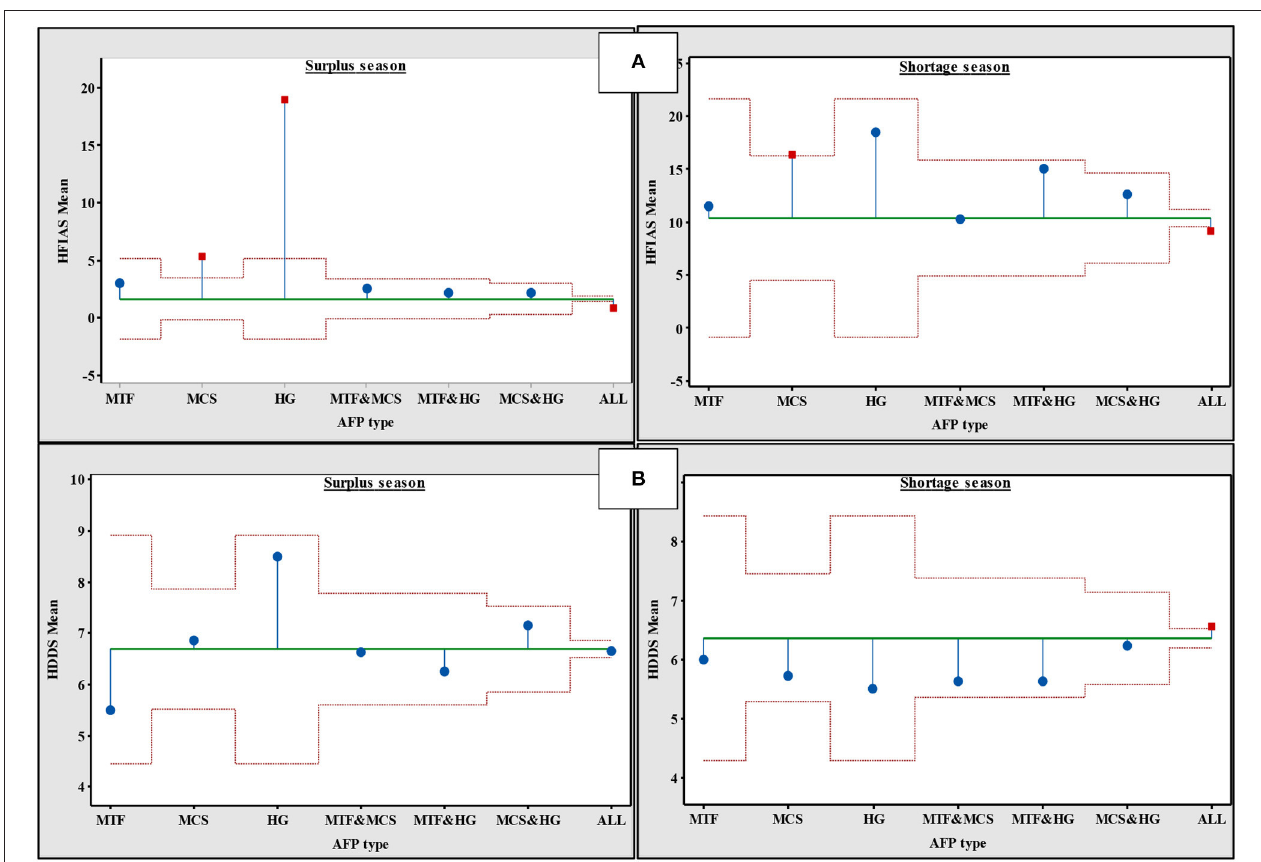
FIGURE 2 | One-way ANOM of household food security indices across seven AFP combinations by household in two seasons ( α homegarden; MCS, multi-storey coffee system; MTF, multipurpose tree on farmland; HFIAS, household food insecurity access scale; HDDS, household dietary diversity